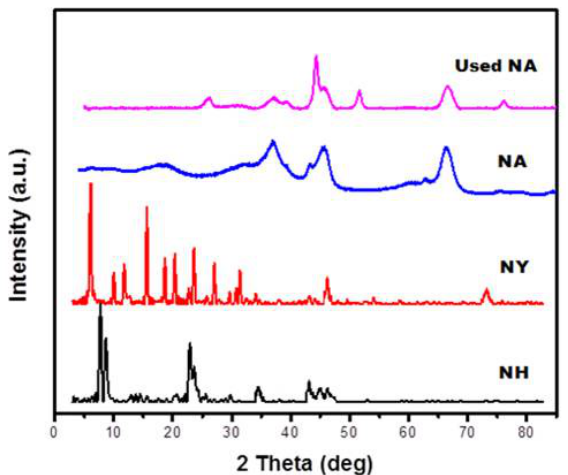
Figure 3. XRD patterns for Ni supported on alumina (NA), Ni supported on Y-zeolite (NY), and Ni supported on H-ZSM-5 (NH) fresh and Ni supported on alumina (NA) used